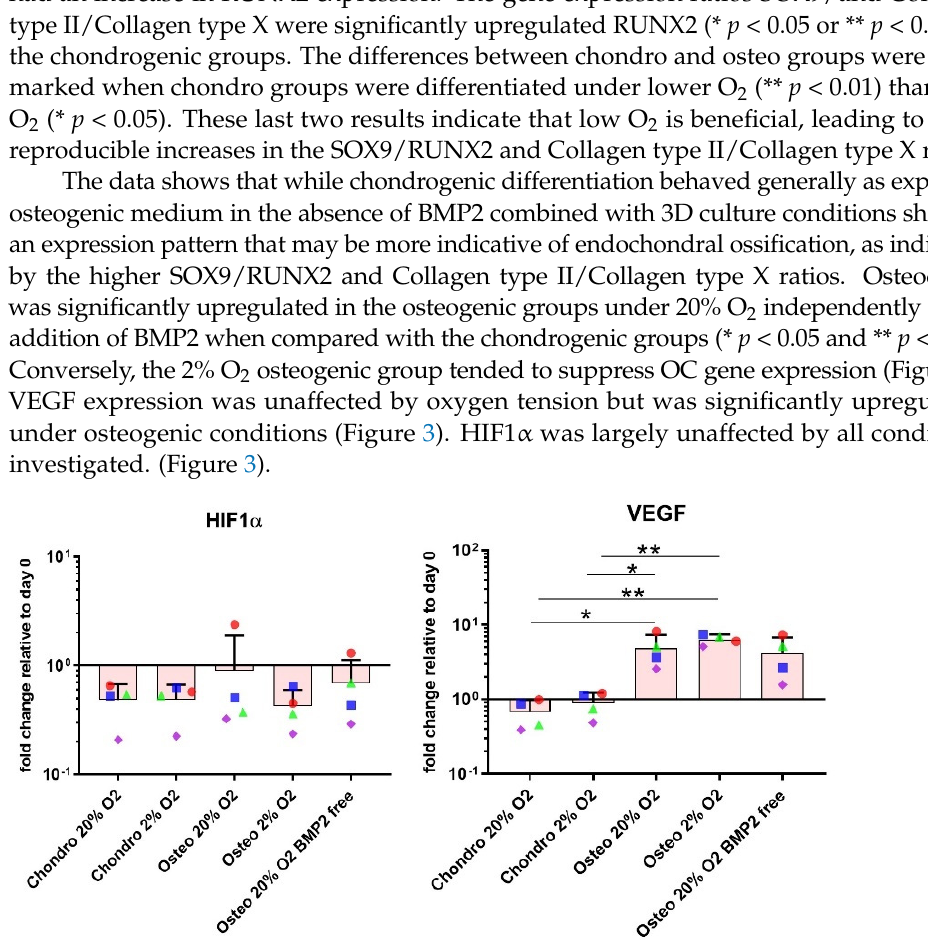
Figure 3. Gene expression measured at day 14 of differentiation by real-time polymerase chain reaction (qPCR). VEGF gene expression was significantly upregulated in the osteogenic groups supplemented with BMP2. Relative quantification of target mRNA was performed according to the comparative Ct method. Values represent the mean and standard deviation of four independent hBMSC donors in experimental triplicate. Statistical significance was defined as * p < 0.05 and ** p < 0.01 .